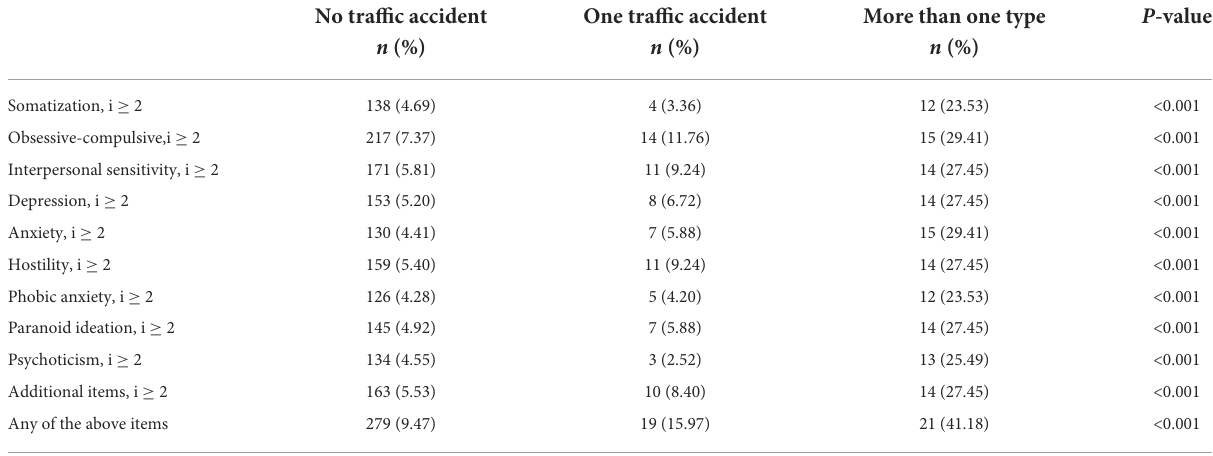
TABLE 5 Prevalence of each psychological symptom with drivers with different types of traffic accidents. No traffic accident One traffic accident